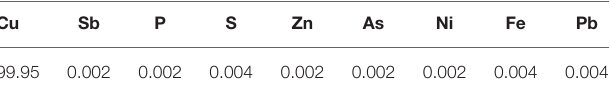
TABLE 2 | Elemental composition of Cu sample (mass fraction, %).